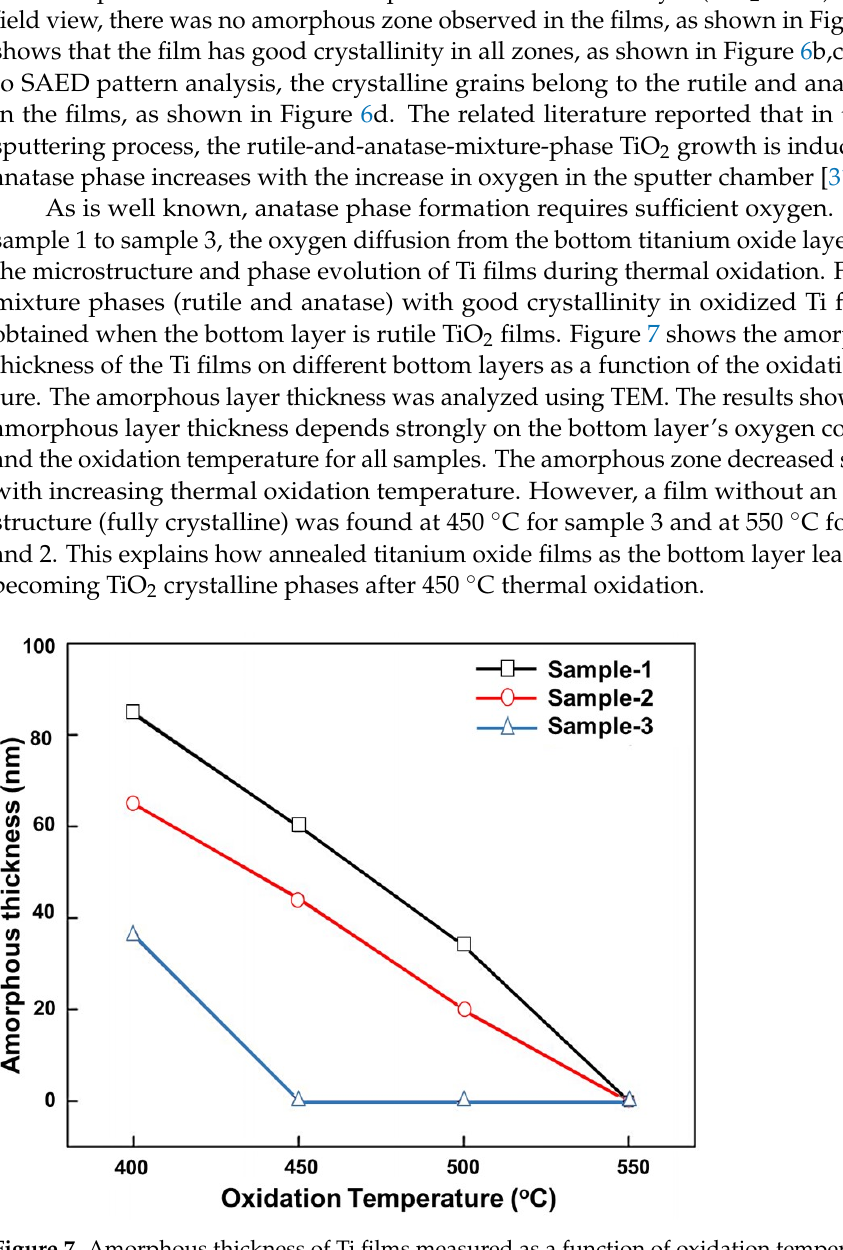
Figure 7. Amorphous thickness of Ti films measured as a function of oxidation temperature.